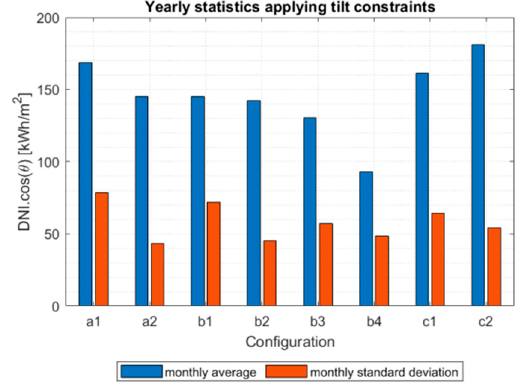
Figure 3. Summary of yearly statistics, applying tilt constraints (Figure 1c) for all geometrical configurations listed in Table 5. The monthly average is plotted in blue, while the monthly standard deviation is plotted in red. Location: Seville, Spain.